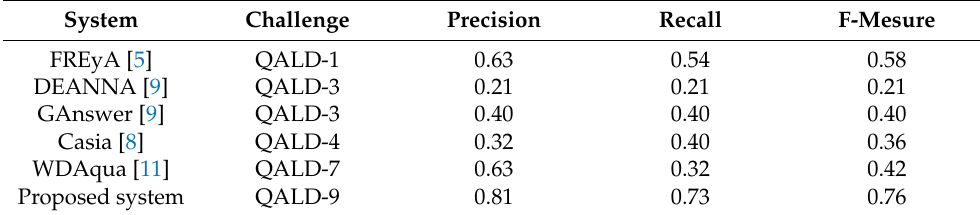
Table 5. Comparison of the proposed system with existing